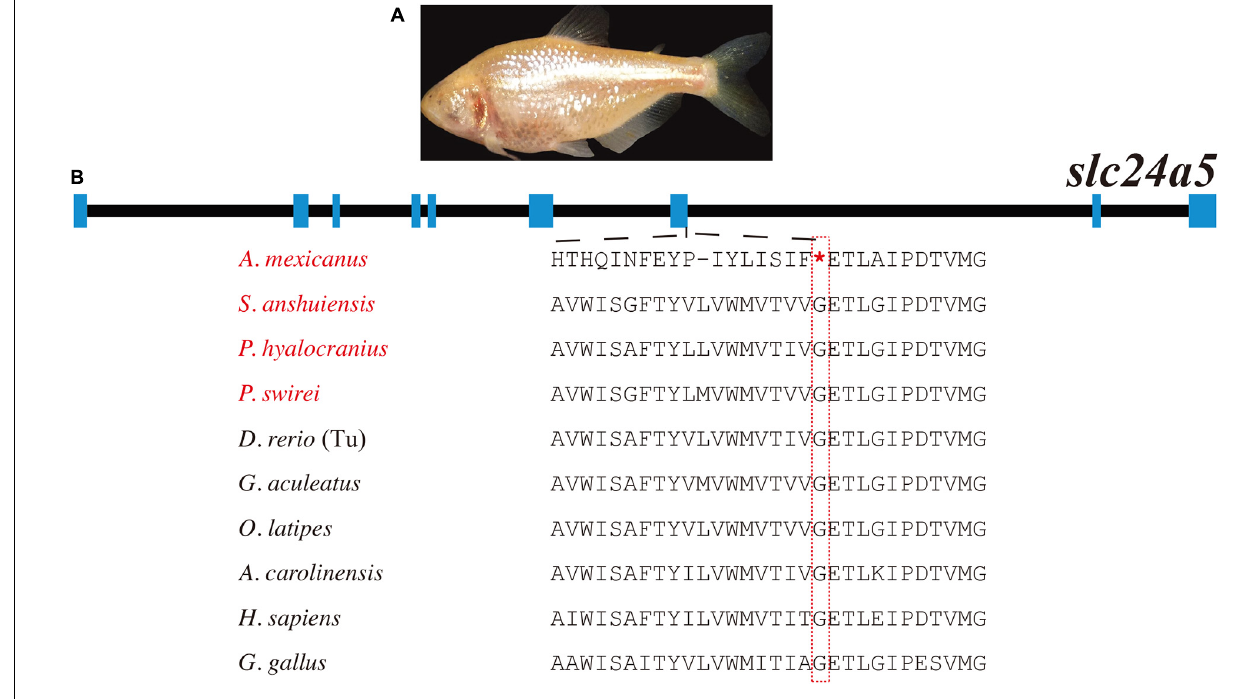
FIGURE 4 | Multiple sequence alignments of slc24a5 in ten representative species. (A) Photo of A. mexicanus (cave population), which was downloaded from Wikipedia Commons (NIH Image Gallery, Bethesda, MD, United States). (B) A nonsense mutation in the slc24a5 exon of A. mexicanus. Species with melanin loss were marked in red. *Represents the premature stop